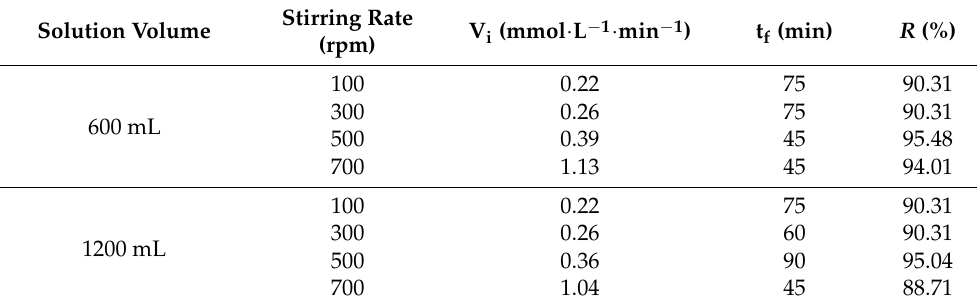
Table 1. End of precipitation time (t f ), initial precipitation rate (V i ), and phosphorus removal efficiency ( R %) for different stirring rates, solution volumes of 600 and 1200 mL, and an initial phosphorus concentration of 200 mg · L − 1